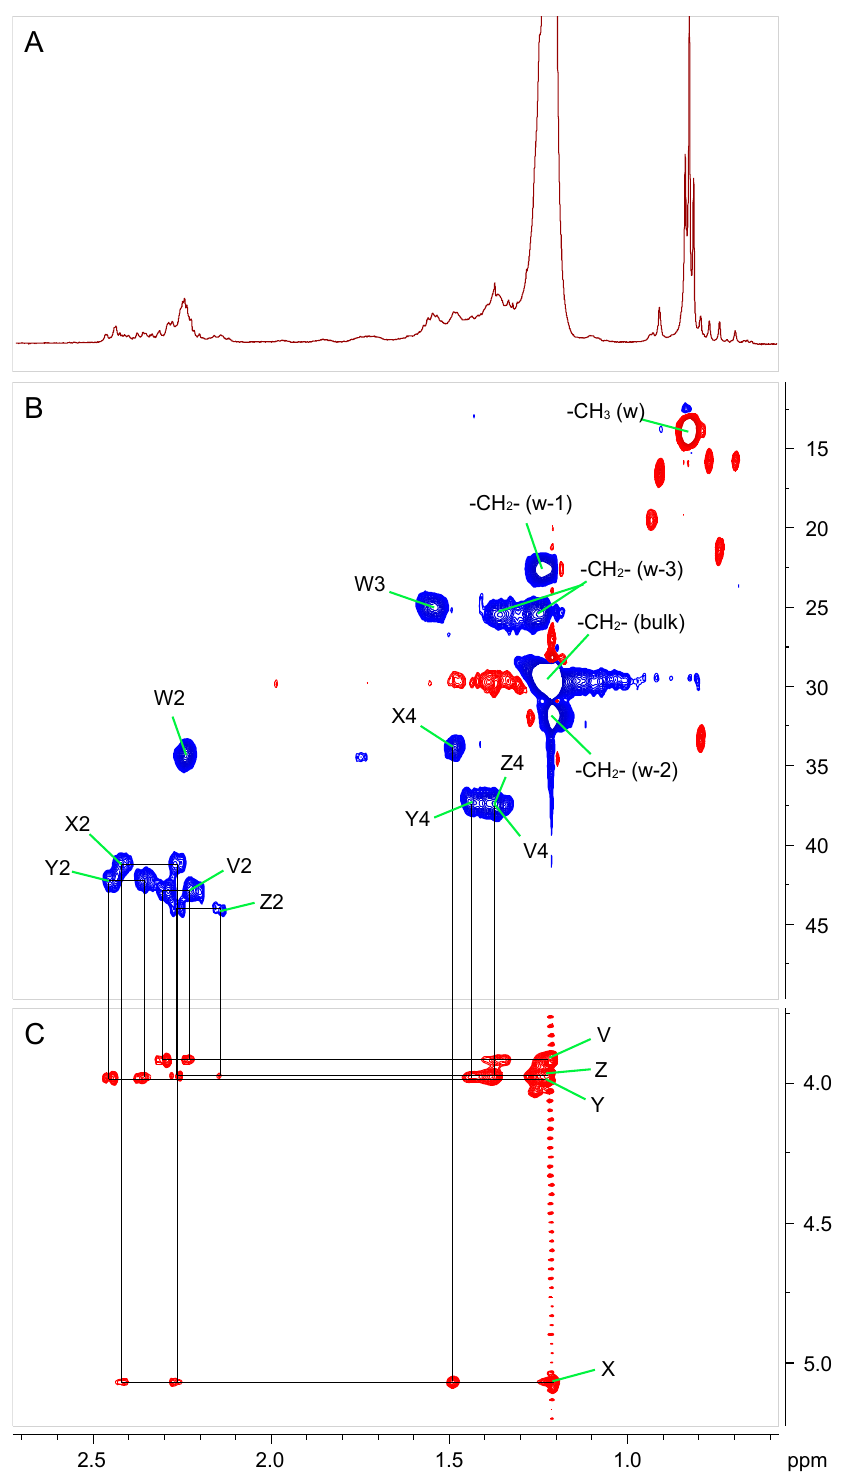
Figure 4. Partial 1 H ( A ), 1 H- 13 C-HSQC ( B ), and 1 H- 1 H total correlation spectroscopy (TOCSY) ( C ) NMR spectra of G. bethesdensis Ko–lipid A in 3:1 CDCl 3 –CD 3 OD solution. The spectra show the region containing most fatty acid signals. The labels are explained in Table 2. Table 2. NMR assignments of fatty acid substituents in the Ko–lipid A of G. bethesdensis . For NMR spectra, refer to Figures 3 and 4.